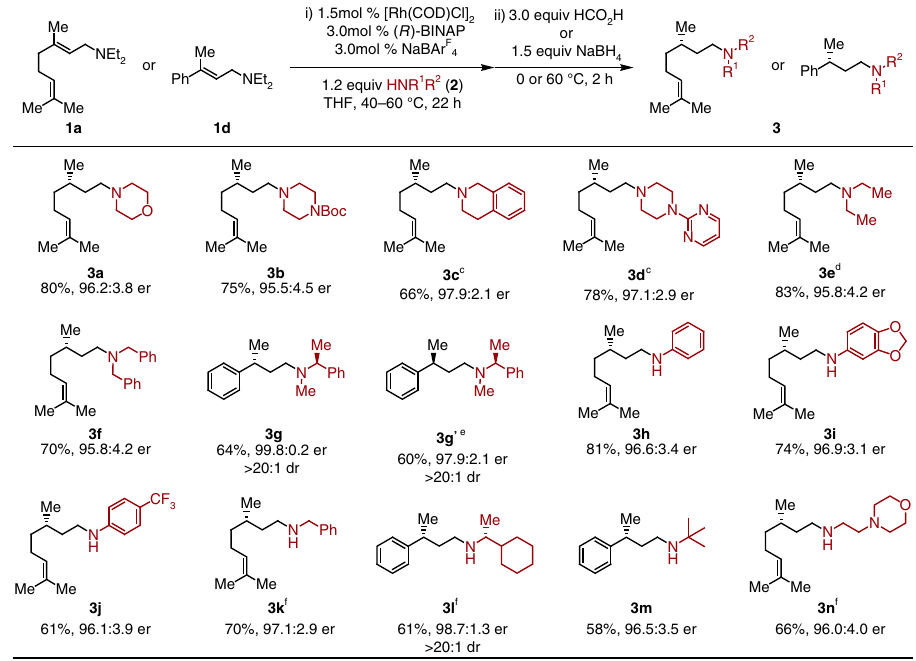
Fig. 3 Scope of amine nucleophiles for the reductive amination of allylamine. a: General reaction conditions: 1a (0.24mmol, 1.0 equiv, E / Z = 97.5:2.5, 40°C for 1st step) or 1b (0.24mmol, 1.0 equiv, E / Z >99:1, 60°C for 1st step) nucleophile 2 (1.2 equiv), hydrogen donor (3.0 equiv), THF (1.2M). b: For 3a – 3g , HCO 2 H used as H 2 donor at 60°C for 2nd step; For 3h – 3n , NaBH 4 (1.5 equiv) used as reductant at 0°C to rt for 2nd step. c: 2c and 2d added together with HCO 2 H. d: No nucleophile added. e: ( S )-BINAP used. f: 2k , 2l , and 2n added after isomerization. See supplementary methods for details. dr diastereomeric ratio